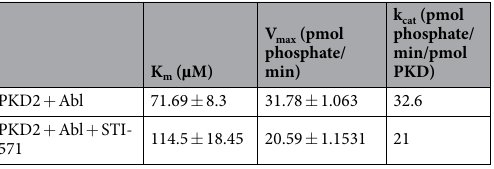
Table 2. Kinetic parameters for the different PKD preparations, values shown are mean ±